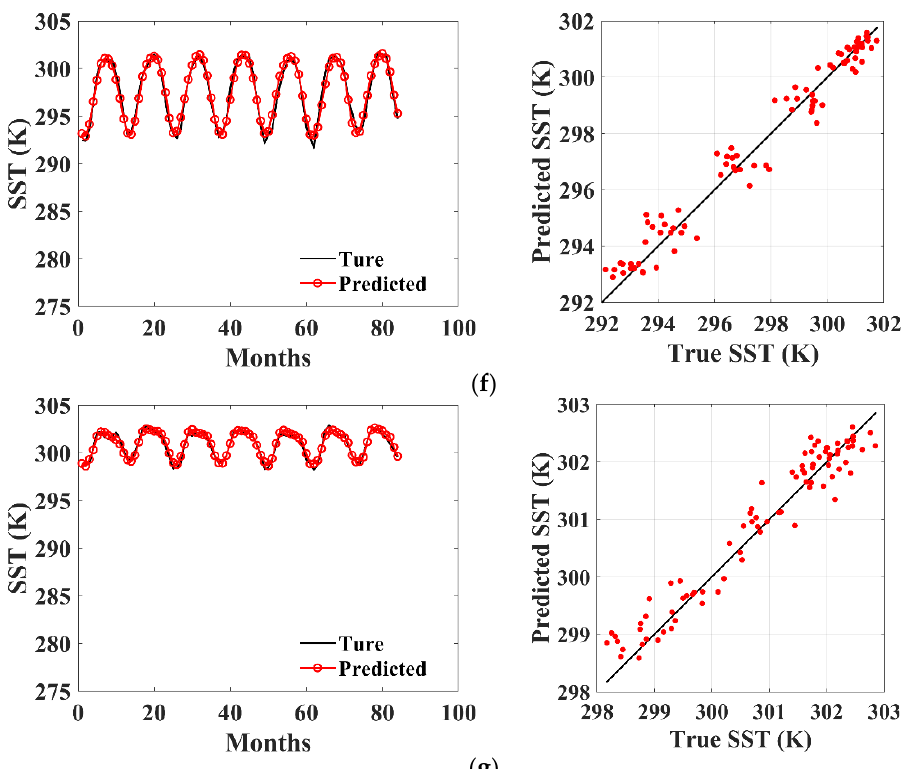
Figure 14. Evaluation of the generalization ability of the model. ( a ) Bohai Sea and north part of Yellow Sea, ( b ) South part of Yellow Sea, ( c ) Part 1 (ID:3 in Table 1) of East China Sea, ( d ) Part 2 (ID:4 in Table 1) of East China Sea, ( e ) Part 1(ID:5 in Table 1) of Tai-wan Strait, ( f ) Part 2(ID:5 in Table 1) of Taiwan Strait and ( g ) South China Sea.